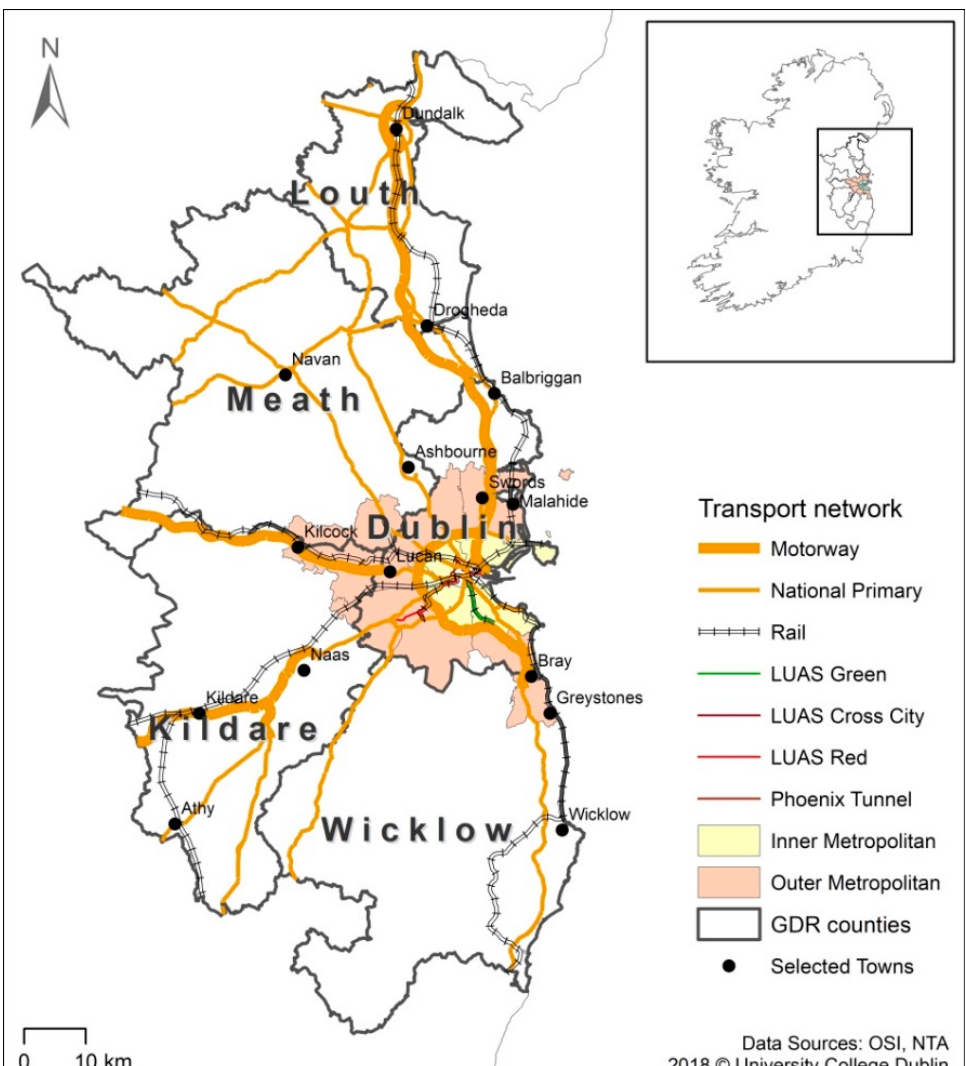
Figure 1. The Greater Dublin Region.